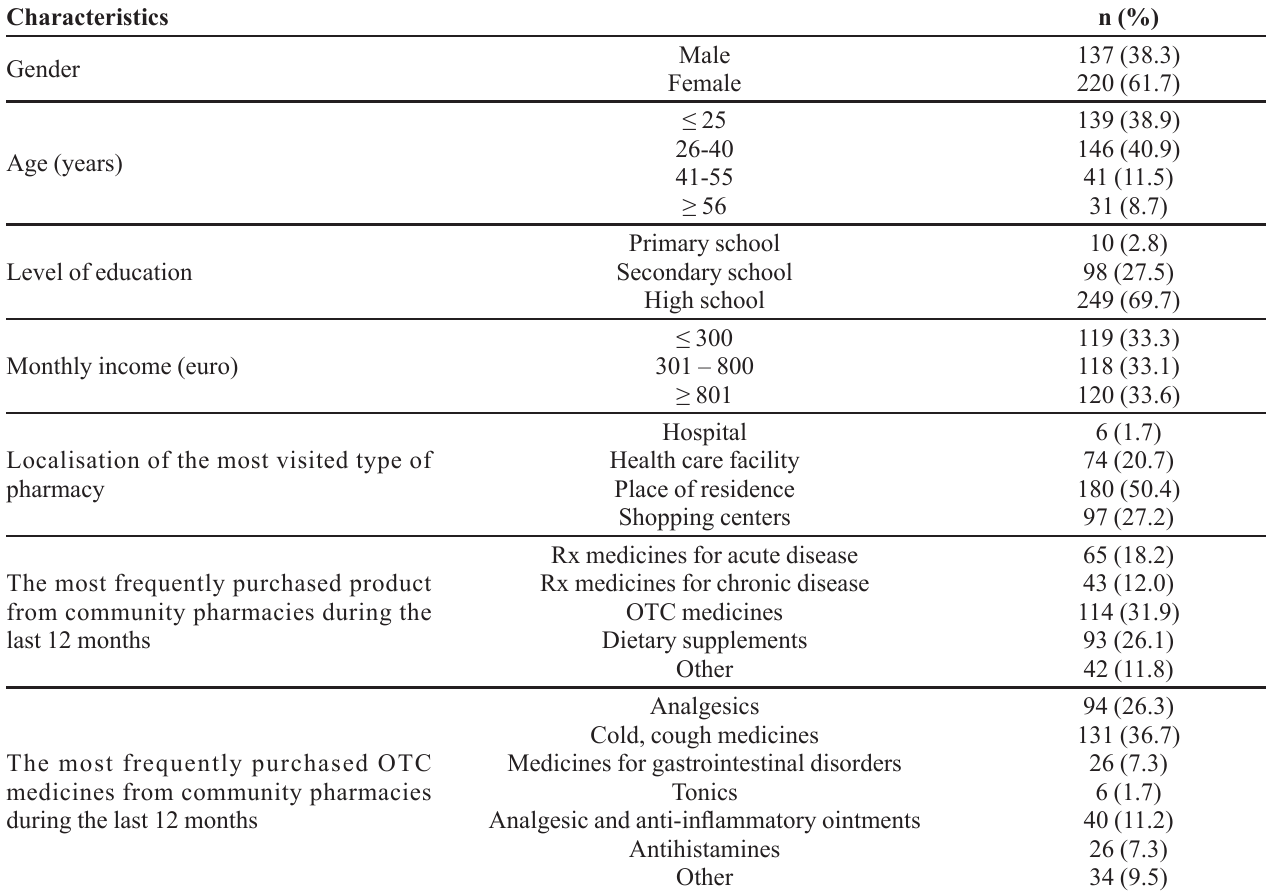
TABLE I - Characteristics of the surveyed population (n=357)